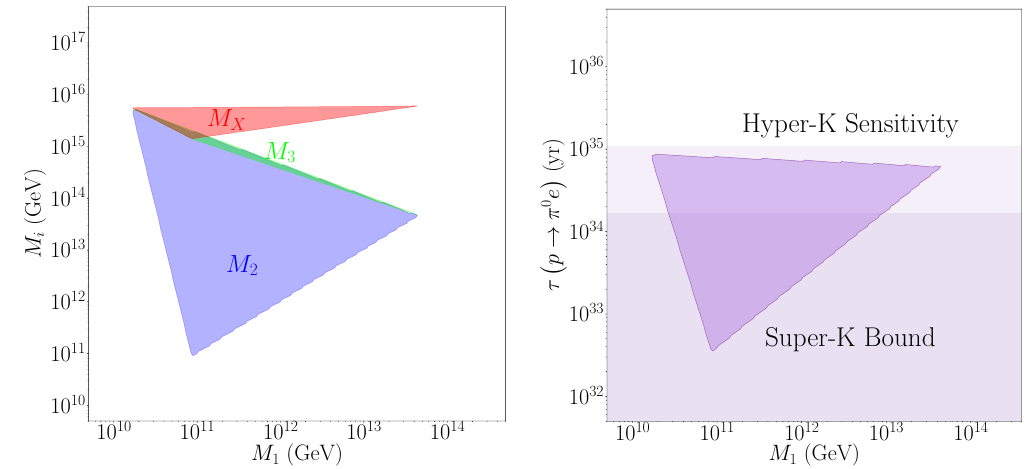
Figure 1 . Left panel: regions of M 2 , M 3 , M X as functions of M 1 allowed by gauge unification; right panel: prediction of proton lifetime as functions of M and future sensitivity of Hyper-K